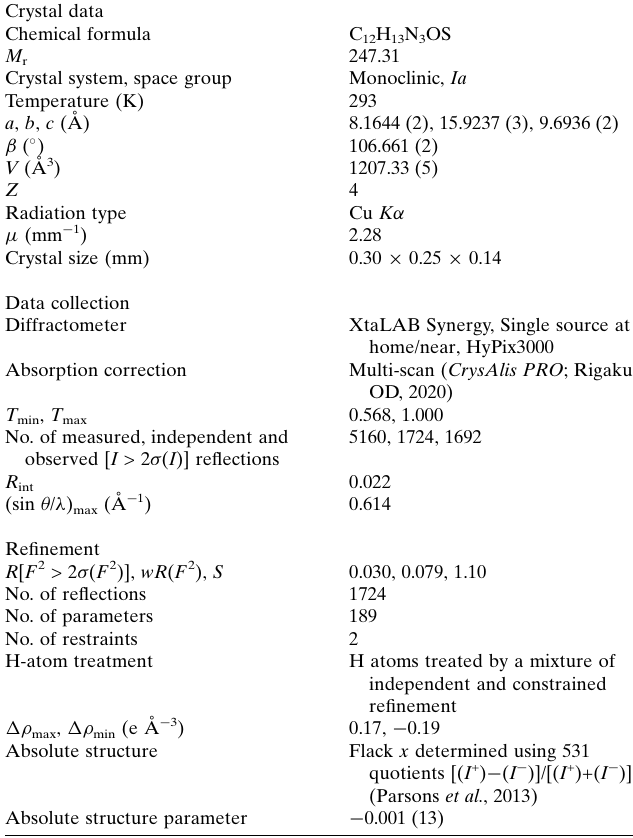
Table 2 Experimental details. Crystal data Chemical